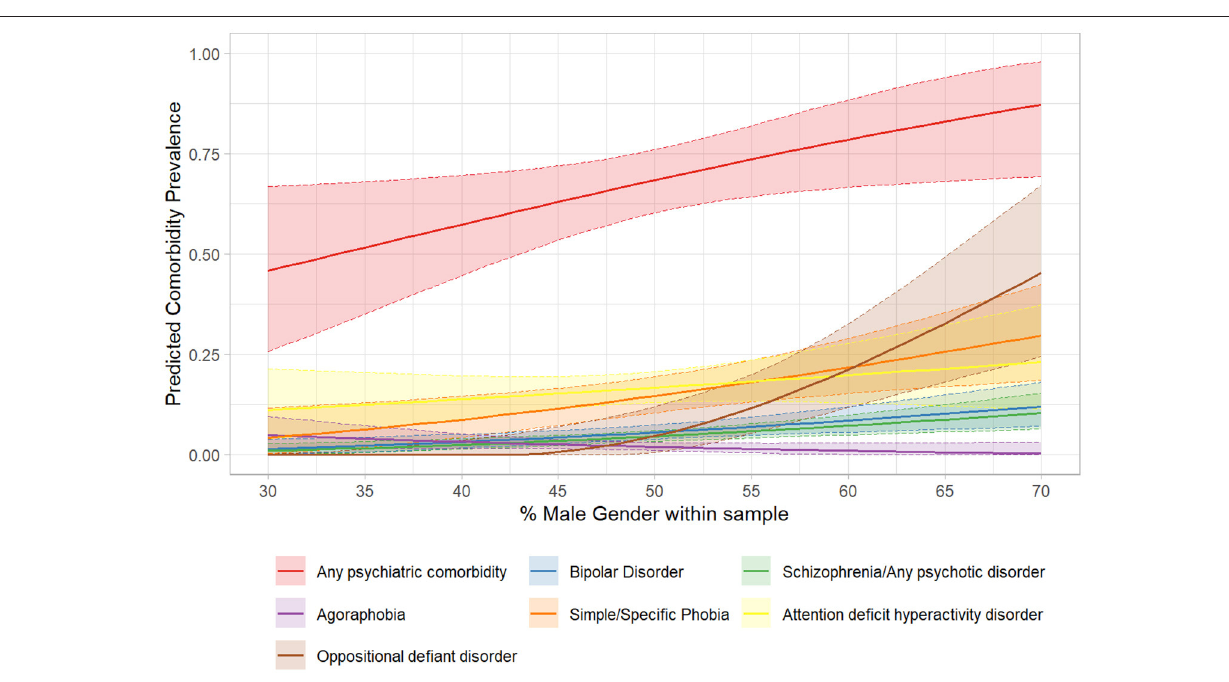
FIGURE 7 | Significant meta-regressions by percentage of males within samples. The prevalence rates of Any Psychiatric Illness & ODD are higher in samples with higher percentage of males. Bipolar Disorder, Schizophrenia/Psychosis & ADHD show a similar trend. examine comorbidity rates from a lifespan perspective.